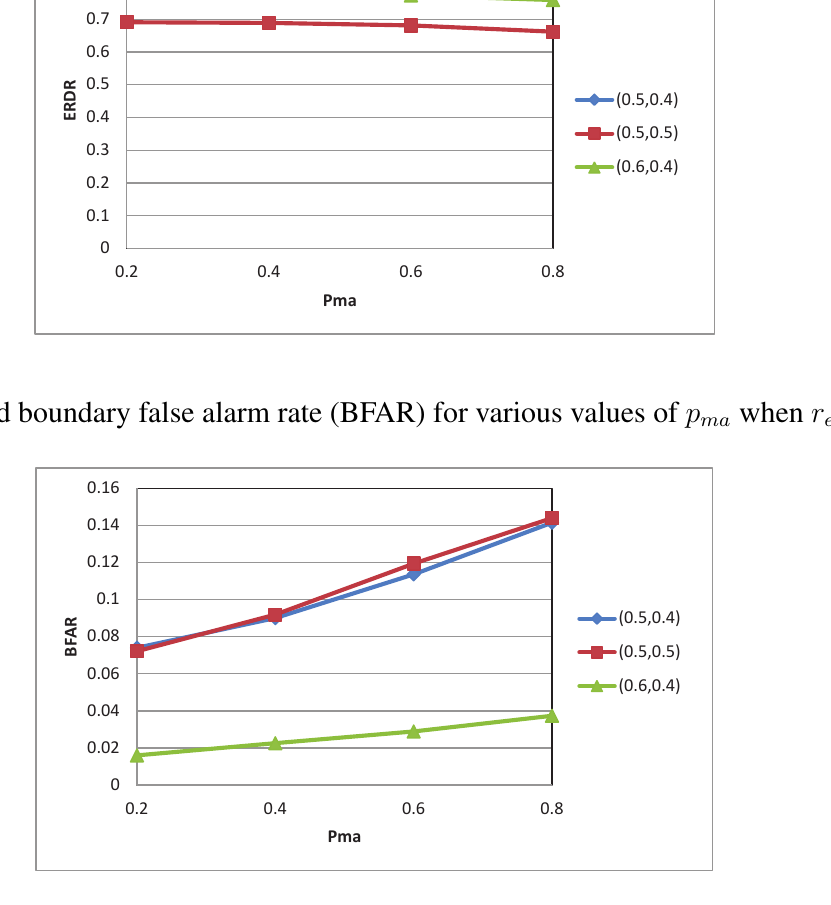
Figure 8. event region detection rate (ERDR) for various values of p